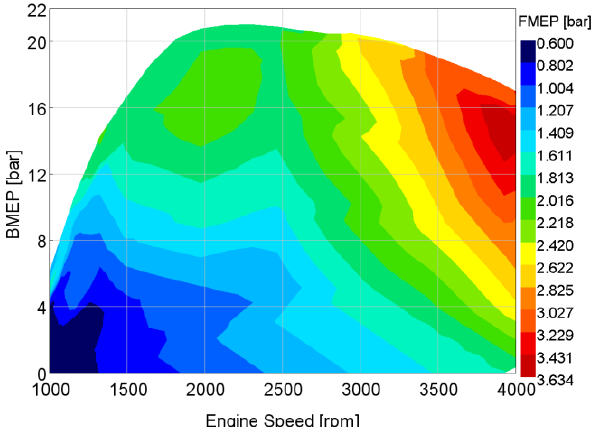
Figure 6. Friction experimental data from the engine used in this work. BMEP: break mean effective pressure.